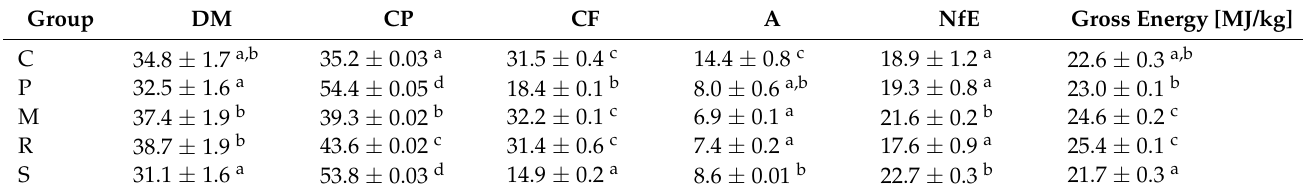
Table 4. Composition of the Black soldier fly meal produced from flies grown on chicken feed (control, C), potato protein (P), maize silage (M), rapeseed oil cake (R), soybean meal (S) substrate over an experimental period of 28 d. DM-dry matter [%], CP—crude protein [%], CF—crude fat [%], A—ashes [%], NfE—nitrogen free extract [100 − (CP + CF + A)]. Significant differences between groups are indicated by different letters ( p > 0.05, n = 3).